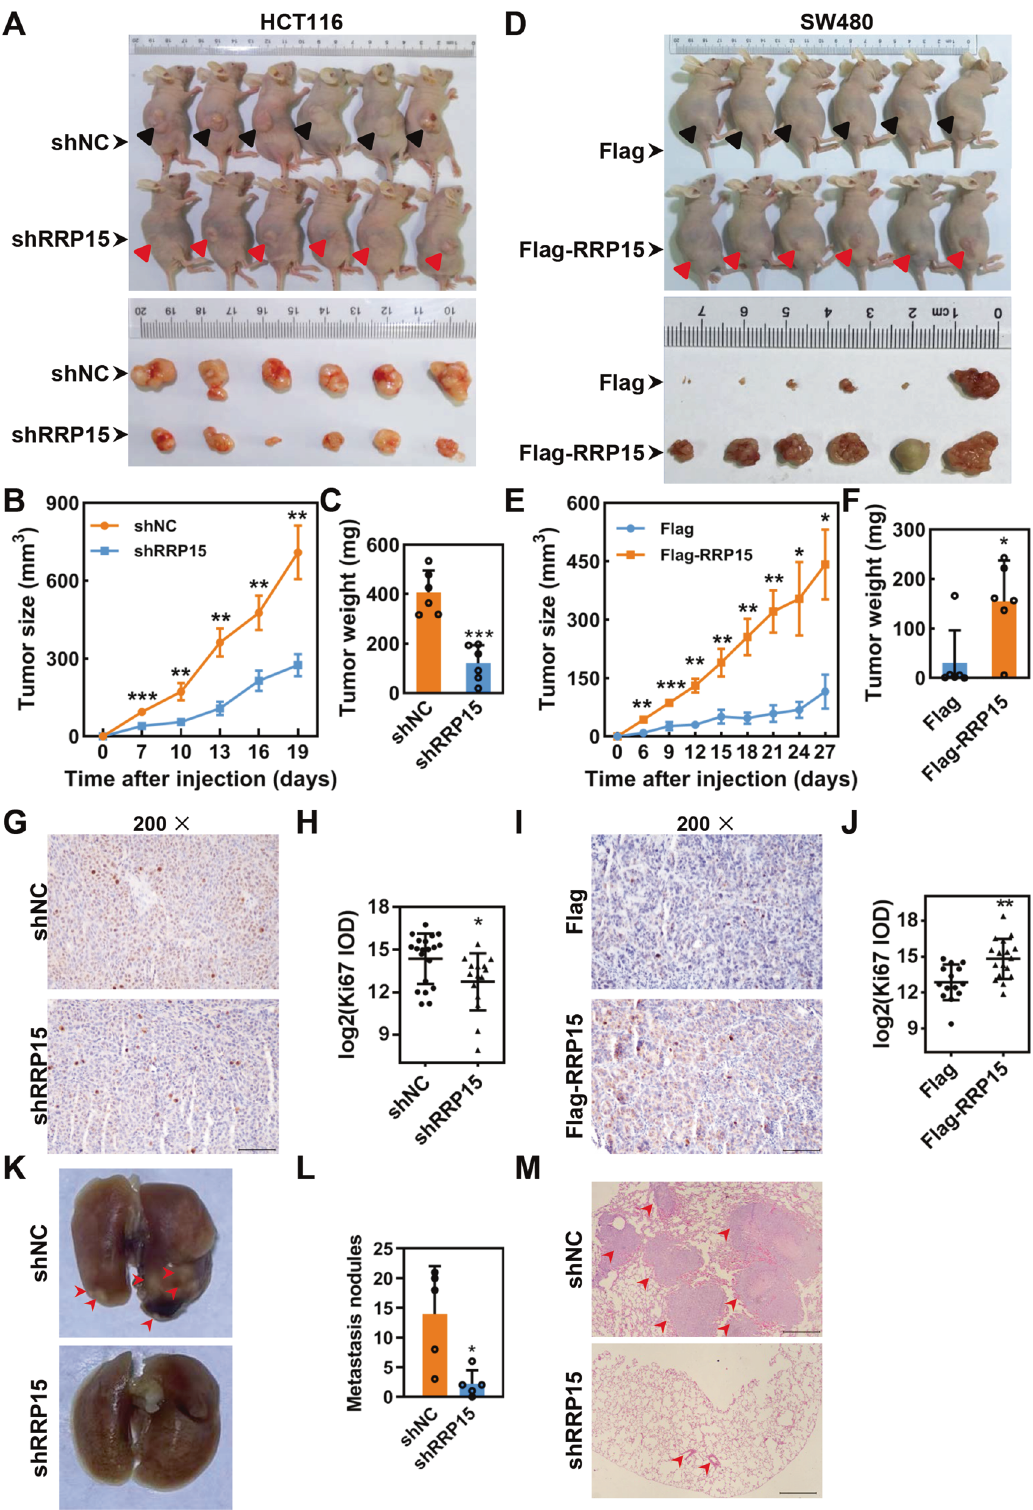
transcription induced by RRP15 KD (Fig. S11). Therefore, we sought to explore other mechanism(s) by which RRP15 regulates Wnt/ β -catenin signaling. Previous studies found that, upon impairment of 40S small subunits biogenesis, the af fi nity of ribosome with a group of mRNAs with a terminal